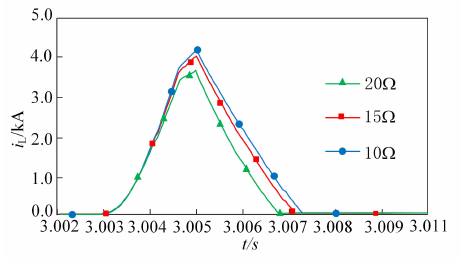
Fig. 6. Relationship between R L and i